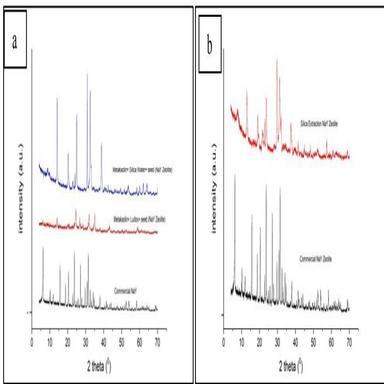
XRD of NaY zeolite from synthetic material